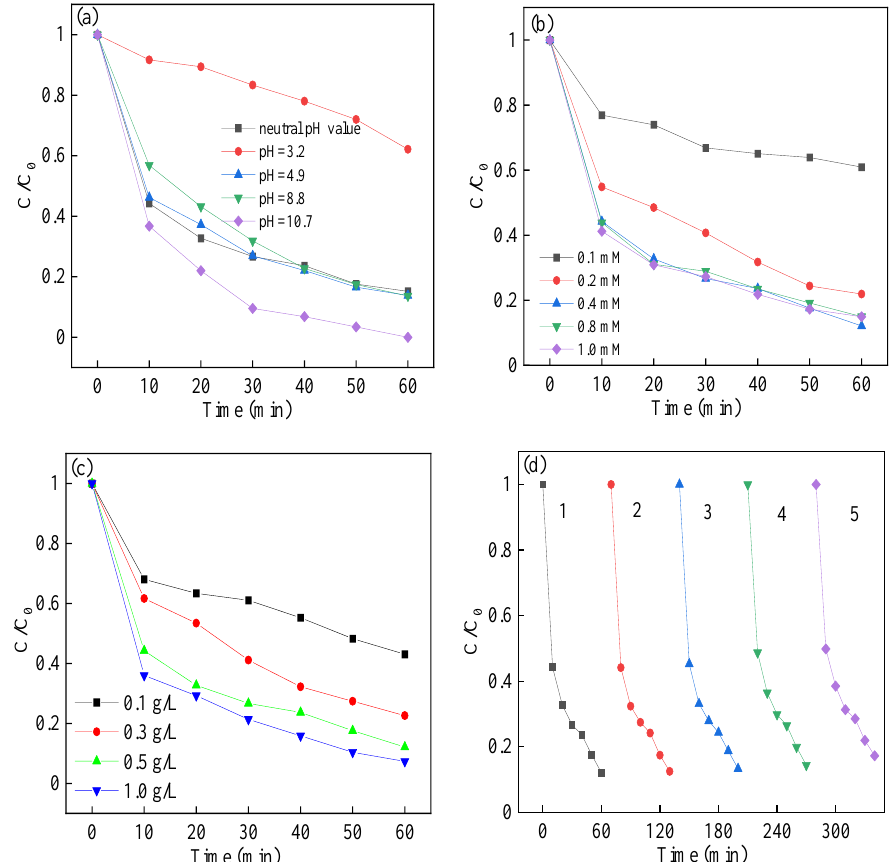
Figure 7. Effect of ( a ) reaction initial pH value; ( b ) PMS concentration; ( c ) catalyst dosage; and ( d ) reuse on RhB degradation in heterogeneous sulfate radical (SR)-photo-Fenton like reaction. Reaction conditions: RhB (20 mg/L), PMS (0.1–1.0 mM), catalyst (0.1–1.0 g/L), pH in the range of 3.2–10.7 in ( a – c ); PMS (0.4 mM), catalyst (0.5 g/L), neutral pH in ( d ).